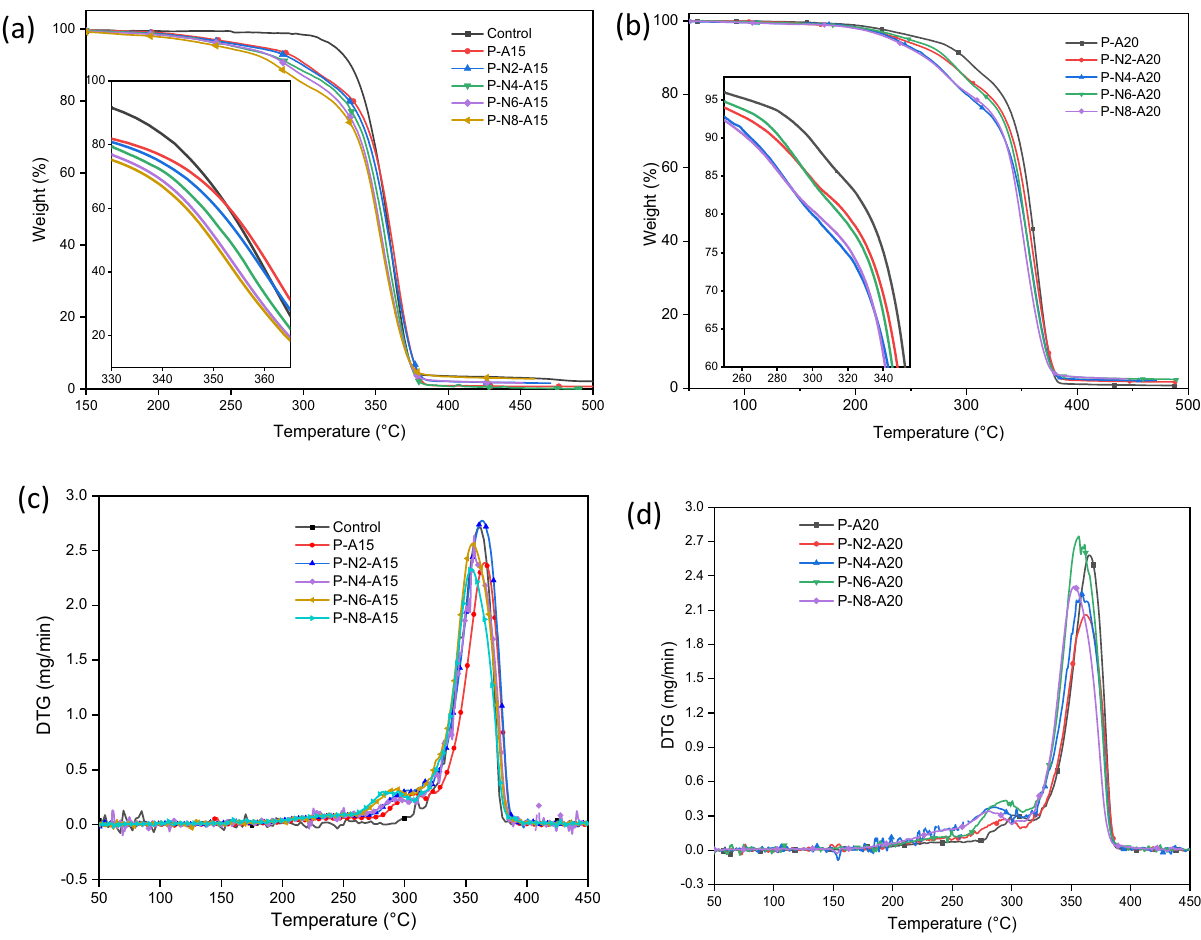
Figure 5: Thermal degradation of the PLA/NFC composites: ( a ) TGA of 15 wt% ATBC plasticized composites, ( b ) TGA of 20 wt% ATBC plasticized composites, ( c ) DTG of 15 wt% ATBC plasticized composites, and ( d ) DTG of 20 wt% ATBC plasticized composites.